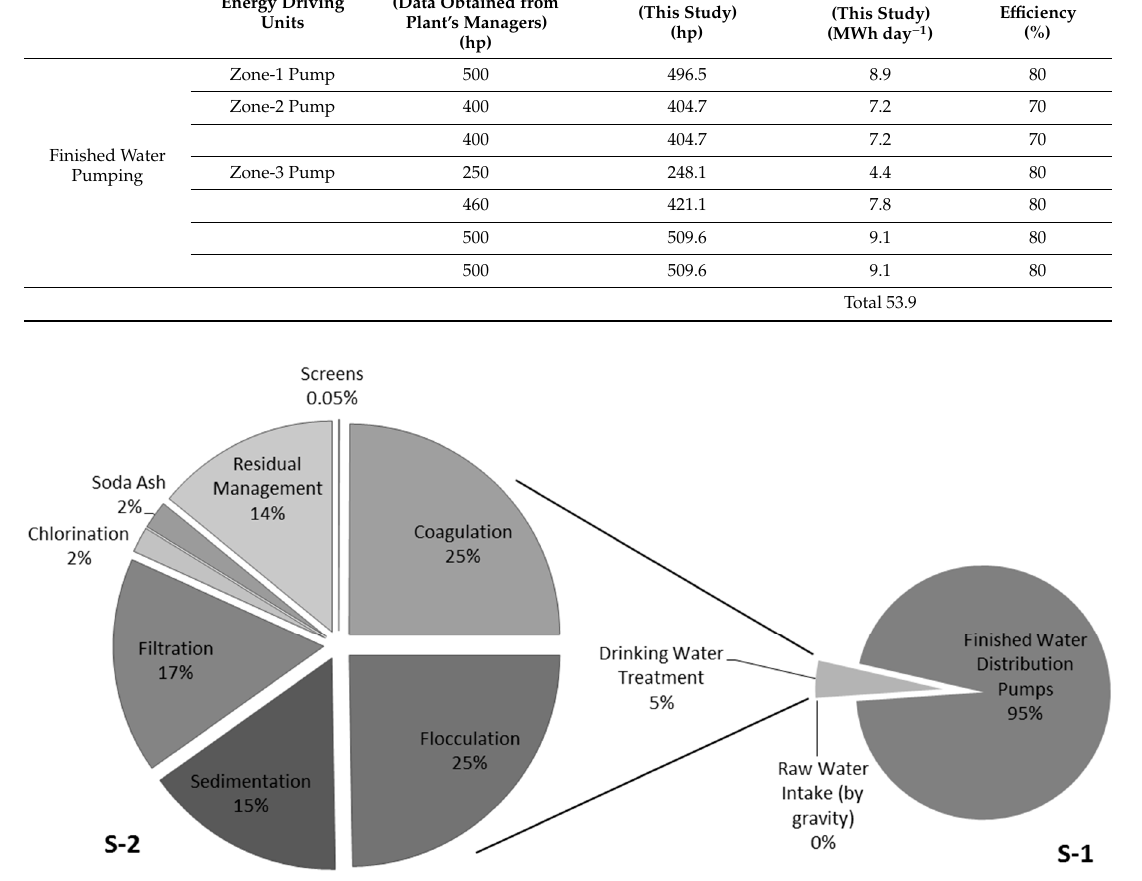
Figure 2. Results for energy consumption by percentage for water intake, water treatment units, and finished water distribution pumps for scenario S-1 (energy consumption of water treatment facility including distribution pumps) and S-2 (energy consumption of water treatment facility excluding distribution pumps).